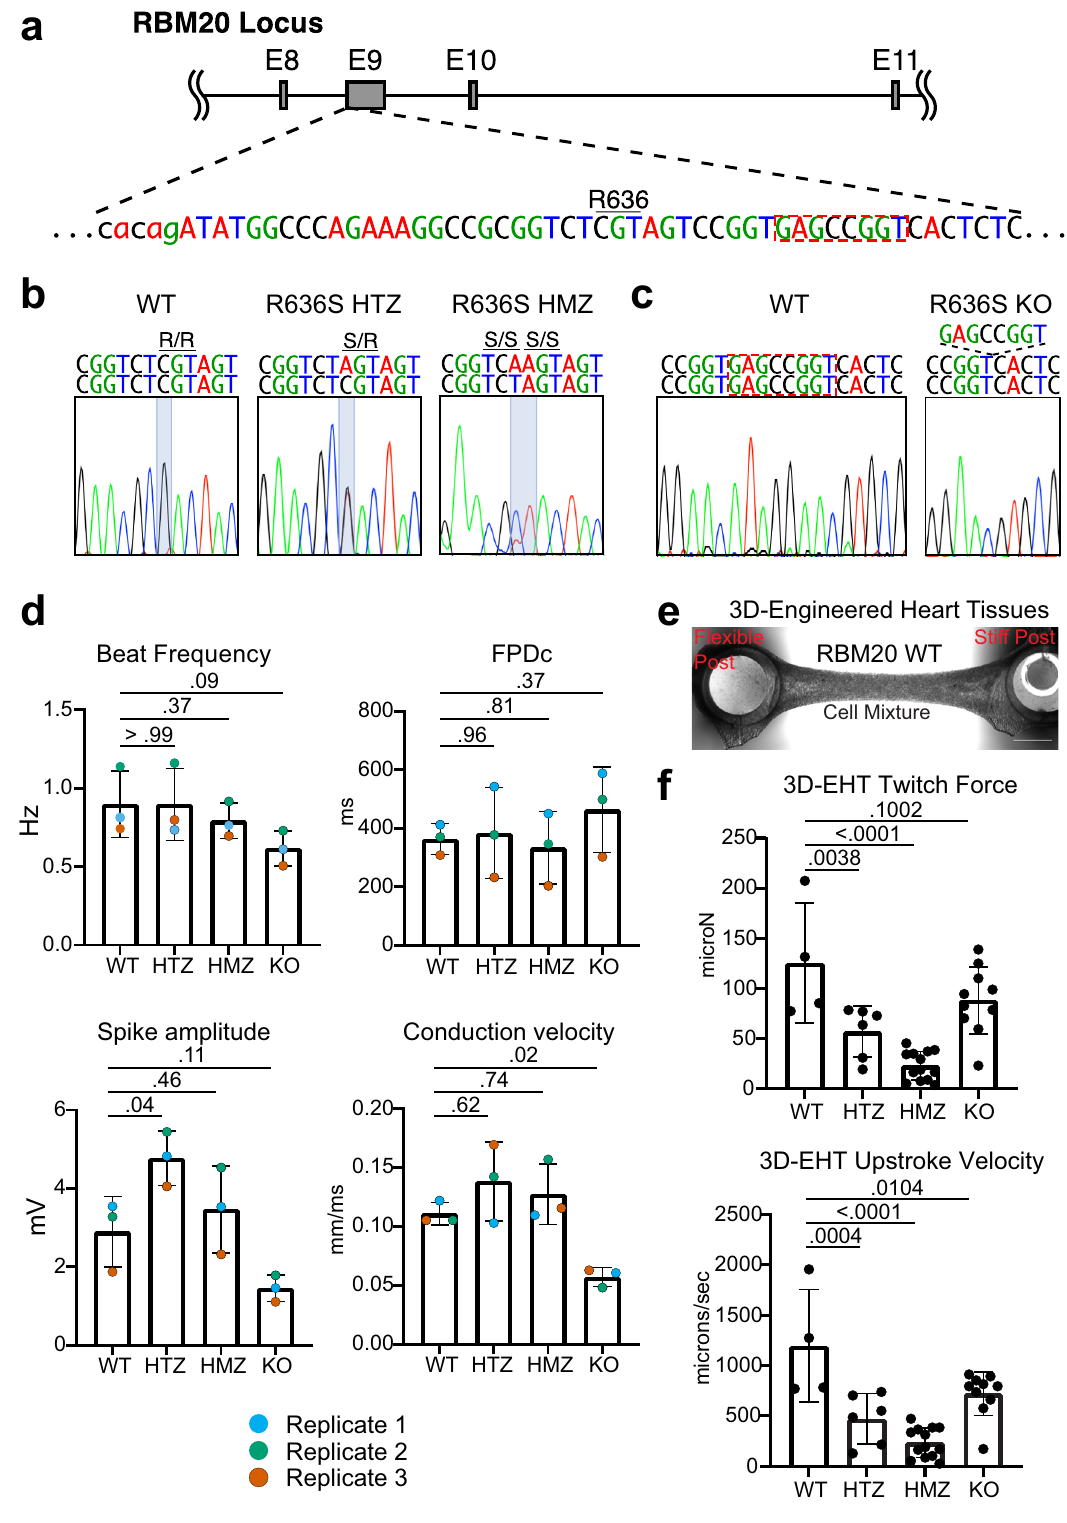
Fig. 1 Generation and functional characterization of mutant iPSC-CMs. a Targeted genomic region of RBM20. The location of R636 and the 8 nucleotides deleted in the 8-bp Del HMZ line are highlighted. b Genomic sequences of the generated RBM20 HTZ and HMZ iPSC lines. c Genomic sequence of the generated RBM20 8-bp Del HMZ line (KO). d iPSC-CM electrophysiological parameters from multi-electrode array (MEA) recordings. Color-coded paired replicates represent biologically independent experiments run in parallel. N = 3 biologically independent experiments. Data represented as mean values ± SEM. e Representative 3D-engineered heart tissues (3D-EHT) from WT and RBM20 mutant cell lines. Phase-contrast microscopy, scale bar: 1 mm. The location of fl exible and glass-stiffened silicone posts is indicated. f Contractile metrics of 3D-EHTs. WT: n = 4, HTZ: n = 6, HMZ: n = 13, KO: n = 10. Data represented as mean values ± SEM. Statistical signi fi cance was calculated using one-way ANOVA with Dunnett ’ s multiple comparisons